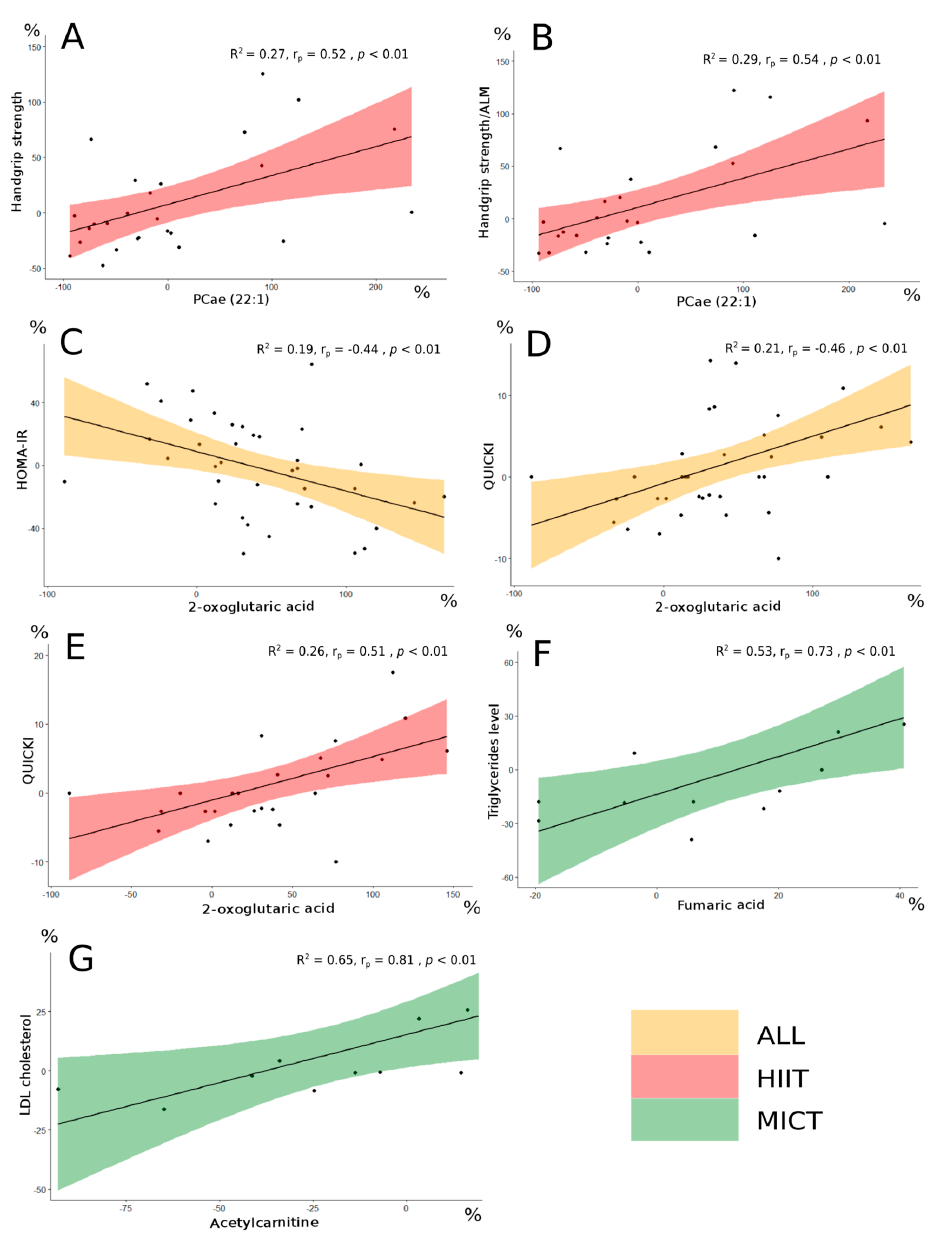
Figure 5. Significant correlations in the different groups between metabolites delta change (%) and clinico-biological parameters delta change (%). R 2 is the coefficient of determination for the